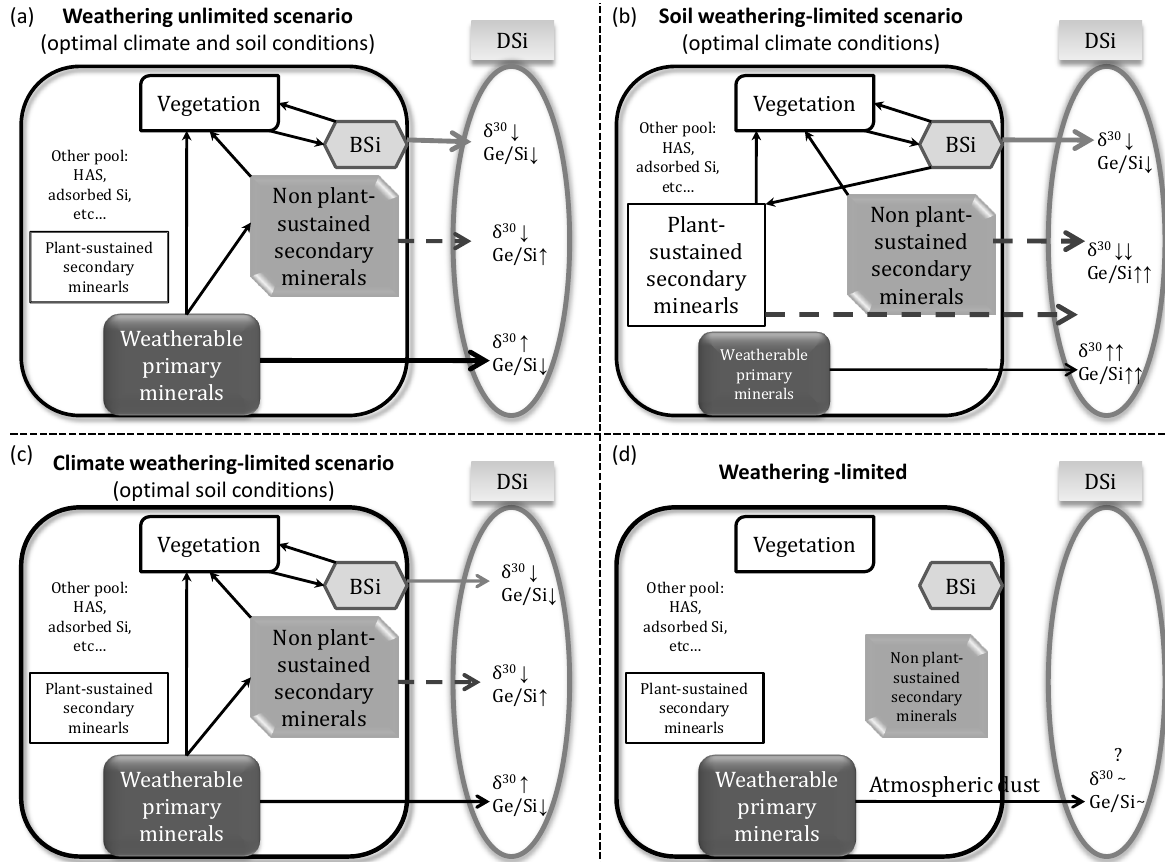
Fig. 3. Schematic representation of the weathering ability of a soil-plant system as a function of the climate (runoff and temperature), soil conditions (presence of weatherable minerals) and recycling by vegetation. The scenarios are described in the text: (a) weathering unlimited (scenario 1); (b) soil weathering-limited (scenario 2); (c) climate weathering-limited (scenario 3); (d) weathering-limited scenario. The arrows represent the dissolution of the various Si pools and its impact on the DSi geochemical ( δ 30 Si, Ge/Si) signatures relative to parental material. The black arrow from the weatherable mineral pool means a DSi signature resulting from weathering of primary minerals assuming secondary precipitate formation and stability. The sizes of the arrows represent relative DSi